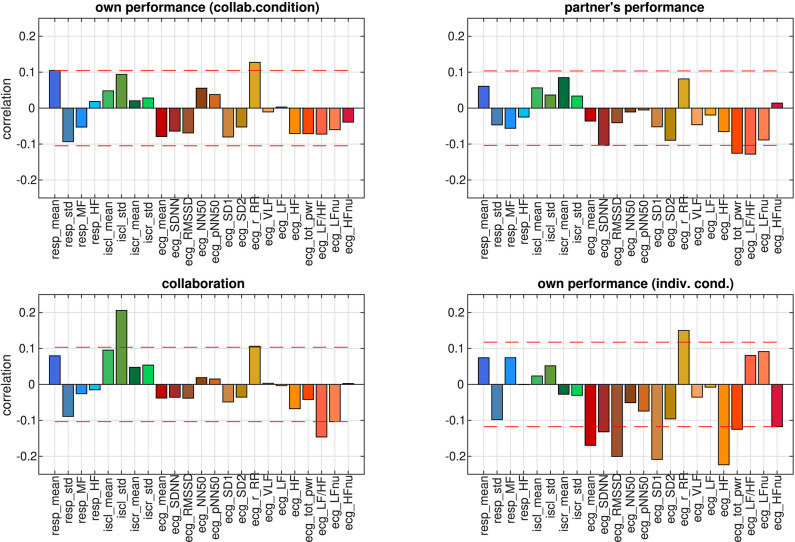
Correlation coefficients between individual autonomic parameters and ratings. RR parameters have blue hues, EDA parameters green colors, and HRV parameters shades of red. Dashed red lines visualize the strength beyond which correlations are significant (p < 0.05, FDR-corrected).